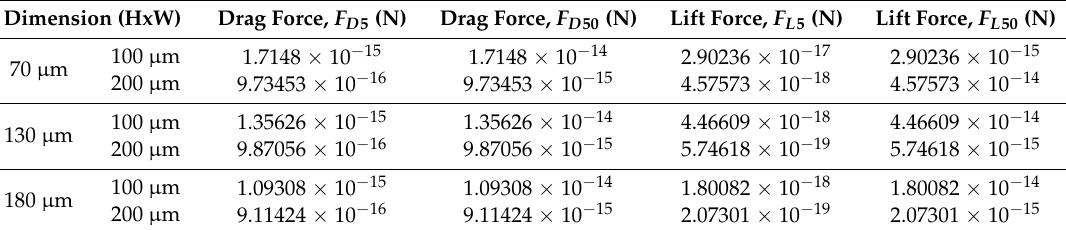
Table 4. Comparison between Dean drag force and lift force for 5 µ m and 50 µ m